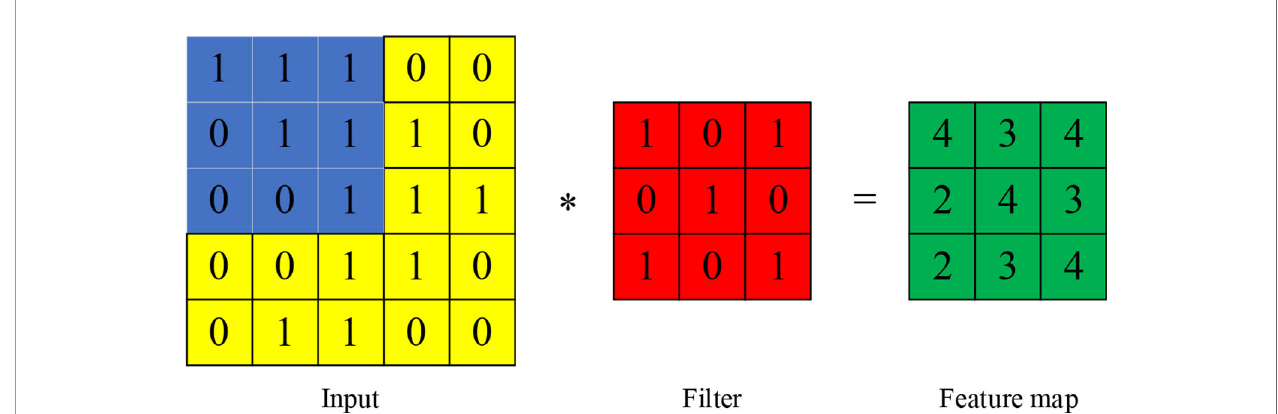
FIGURE 2 | The basic process of convolution calculation. Among them, the blue part and the red part are multiplied bit by bit to obtain a set of green local feature values. In this way, the fi xed-size blue region moves from left to right, from top to bottom in turn, and then multiplies the red part bit by bit to get all calculation results.